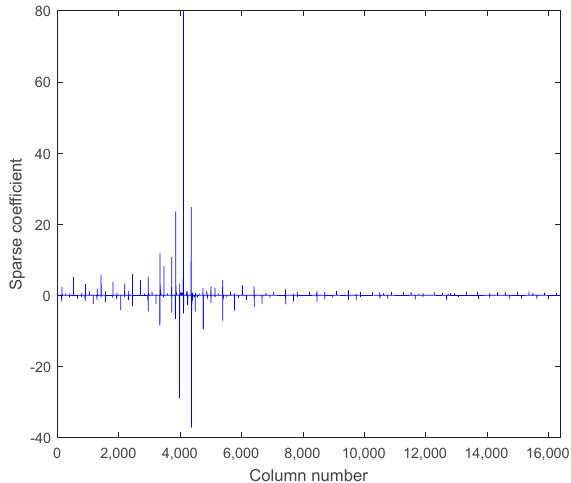
Figure 9. Sparse coefficients of a set of normal current signal.